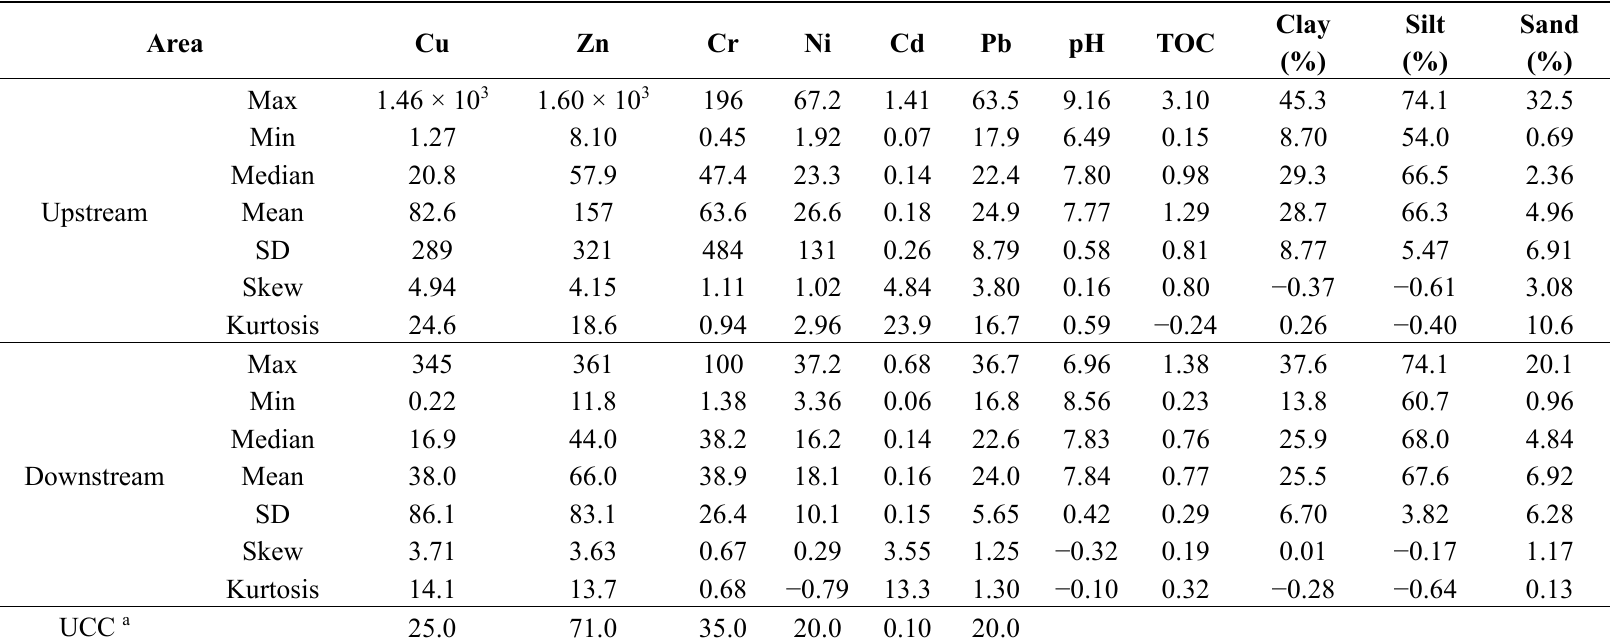
Table 1. Metal concentrations in sediments from the upstream and downstream reaches. Area